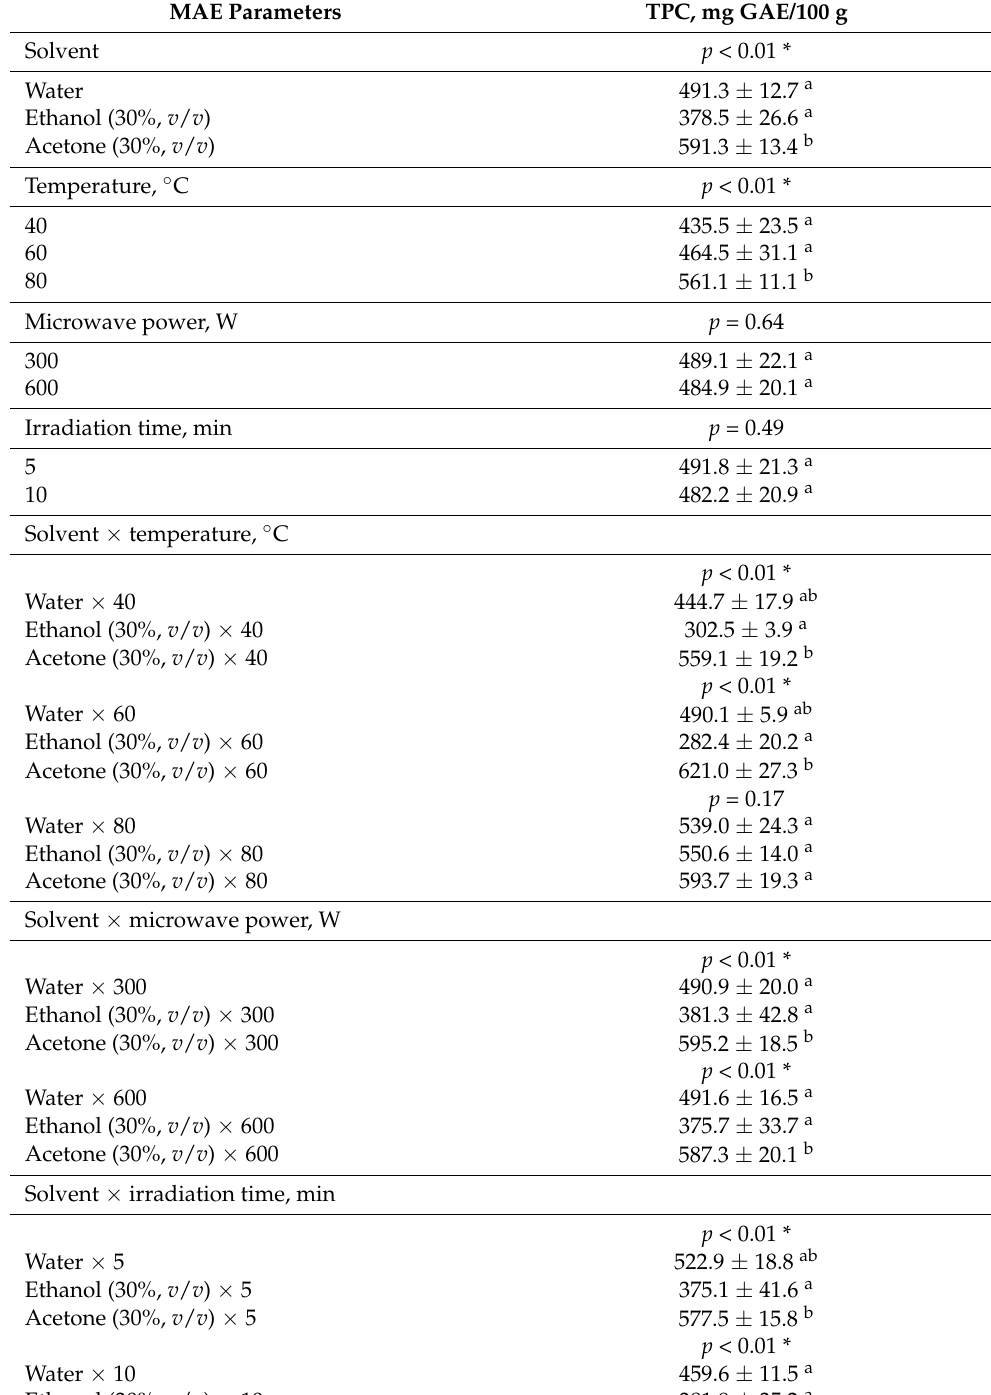
Table 2. TPC in fennel seeds extracts influenced by the main parameters of